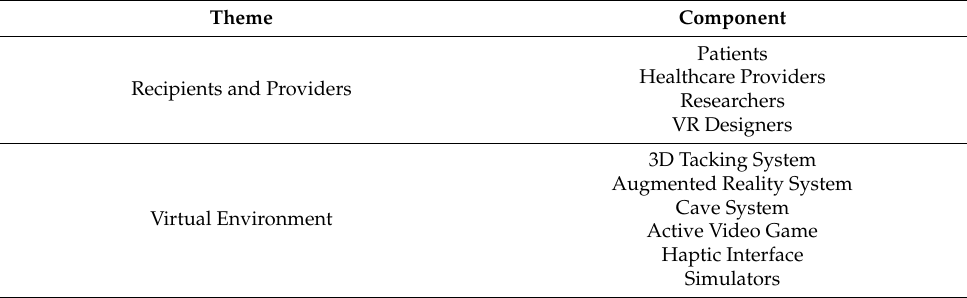
Figure 1. Flowchart of the systematic search and screening process. Table 1. The themes and components of the VREHAB